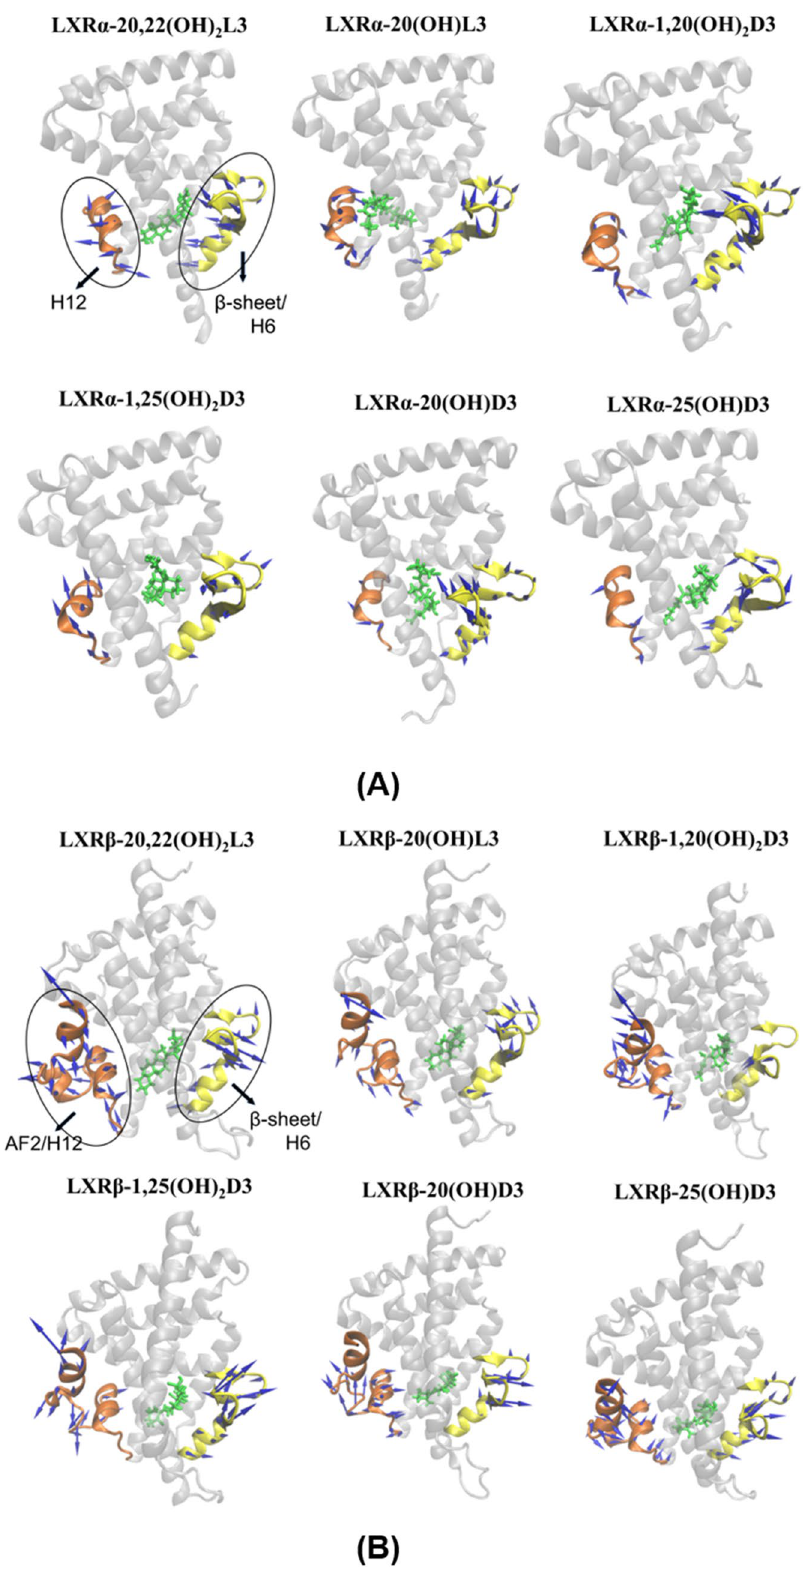
Figure 8. Varied principal dynamic motion of helix 12/AF-2 region (in brown color) and the β-sheet/helix 6 (in yellow color) in the ligand-binding pocket of LXRα ( A ) and LXRβ ( B ) by binding with different D3 and L3 derivatives. LXRα and LXRβ were shown as new cartoon and molecules were shown as licorice in green. Arrows for principal dynamic motion are shown as blue. The images were made with VMD (v1.9.2, http:// www. ks. uiuc. edu/ Resea rch/ vmd/) 101 based on principal component analysis (PCA) of our molecular dynamics simulation